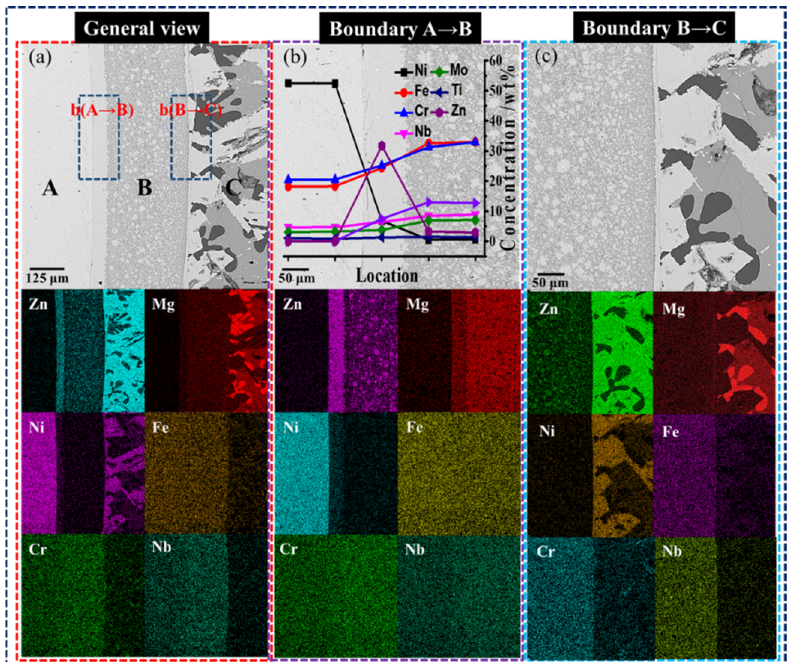
Figure 5. BSE images and elemental mapping of the sample produced from 600 °C. ( a ) SEM images of alloy and Mg-Zn alloy with a boundary; ( b ) SEM image of the alloy and residual with a boundary; ( c ) SEM images of residual and Mg-Zn alloy with a boundary; A-Unreacted superalloy; B-Residual layer rich in Fe and Cr; C-Generated Mg-Zn-Ni alloy.